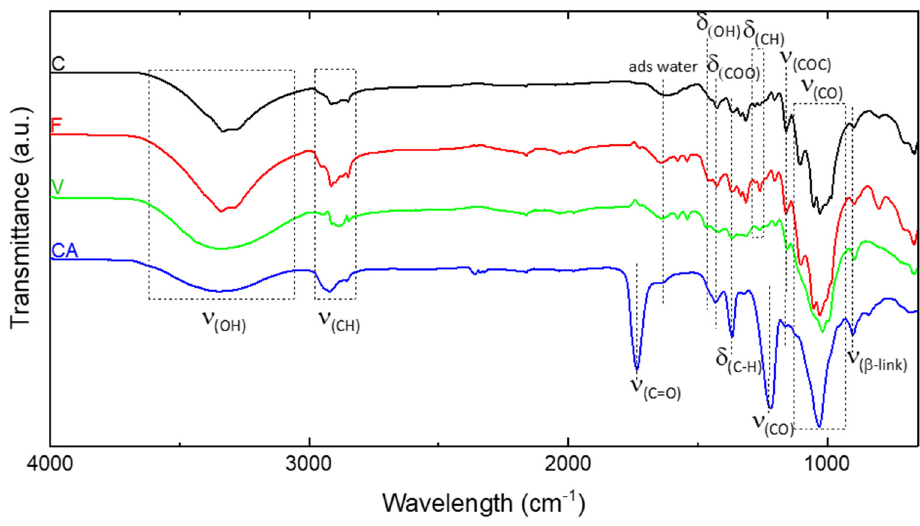
Figure 2. FT-IR spectrum of C, F, V and CA fibers.